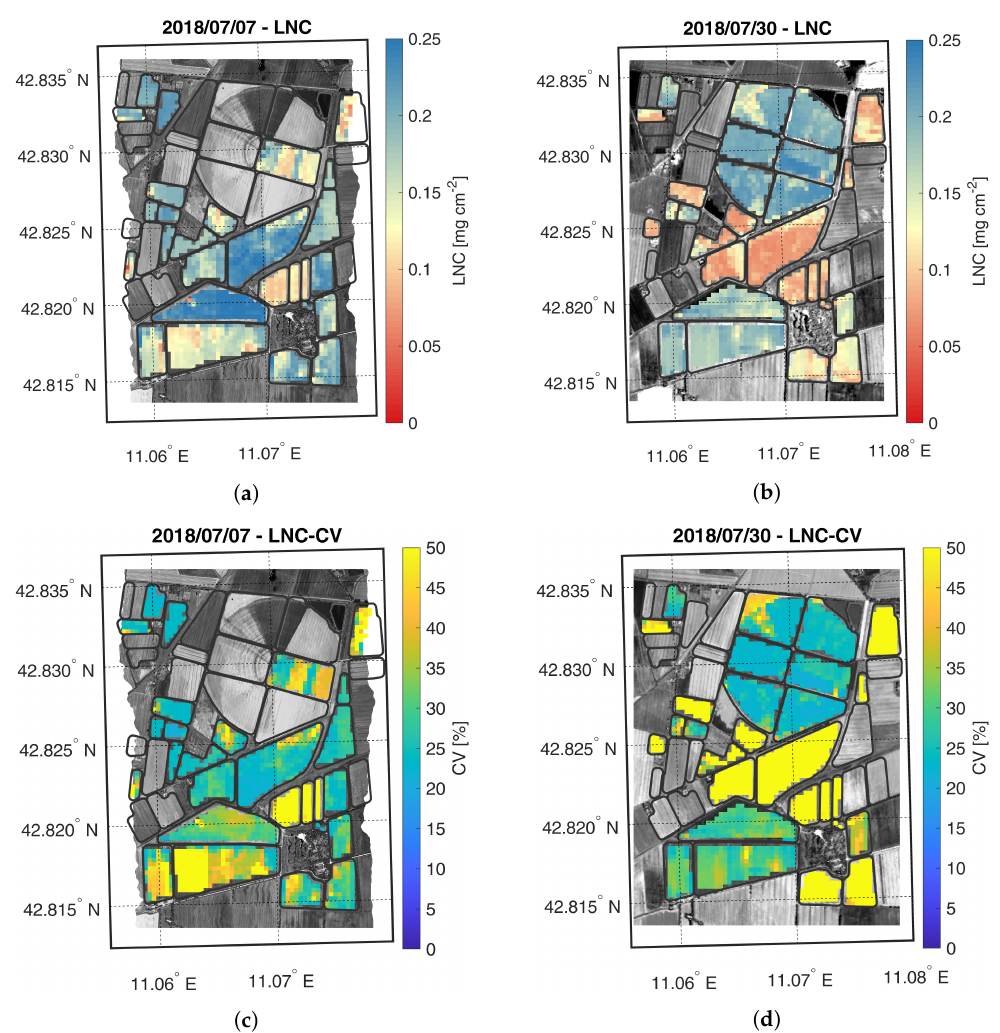
Figure 6. Maps of estimated LNC ( a , b ) and related CV ( c , d ) generated from synthetic CHIME-like images, simulated from the Hyplant-DUAL dataset acquired on 7 and 30 July 2018. The CCC maps are shown in Figure 7. As expected, on the first date, the HFC field shows higher CCC values than the LFC field. On the second date, the CCC maps of the two fields tend to have more similar values. Differently from LCC, the average CCC value in the HFC field decreases between the two acquisitions, suggesting a decrease of the LAI values, in agreement with the phenological phase of maize already in the reproductive growth